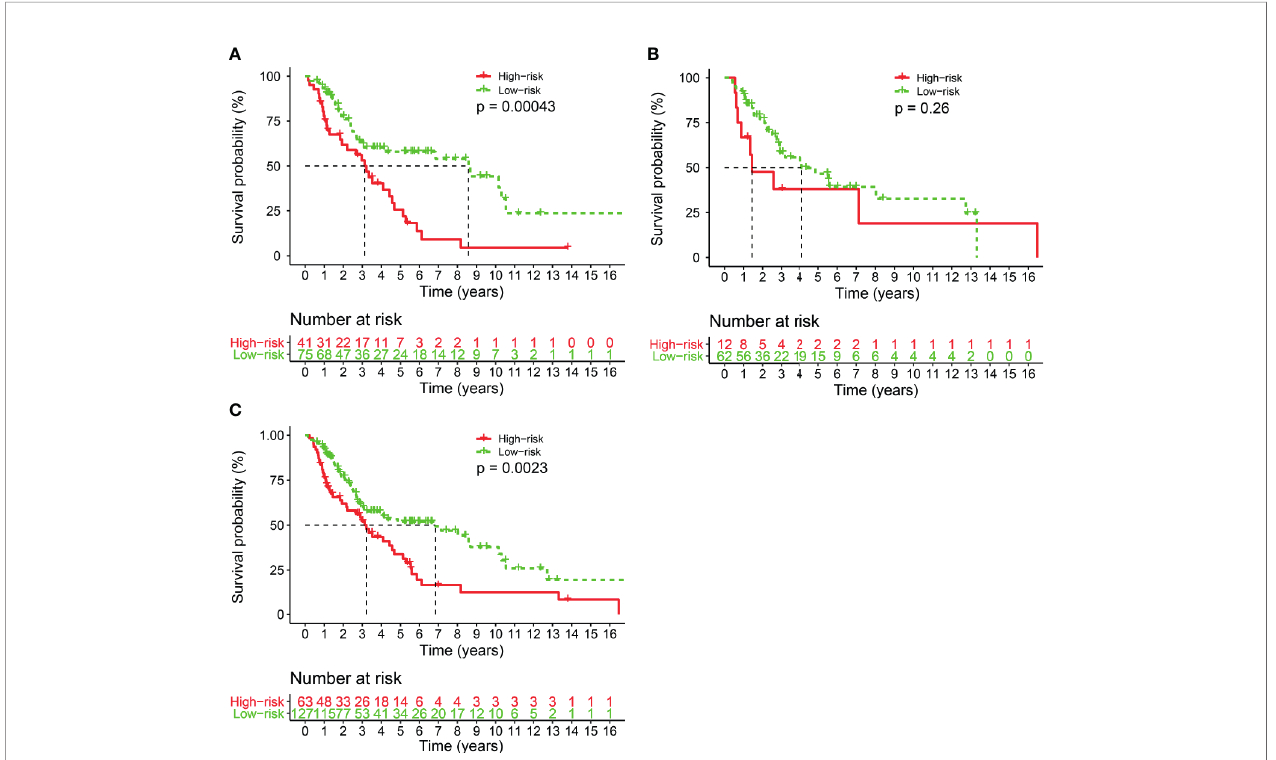
FIGURE 3 | The comparison of overall survival between the high- and low-risk groups strati fi ed by IHC score. (A) The Discovery cohort, (B) the validation cohort, and (C) the total